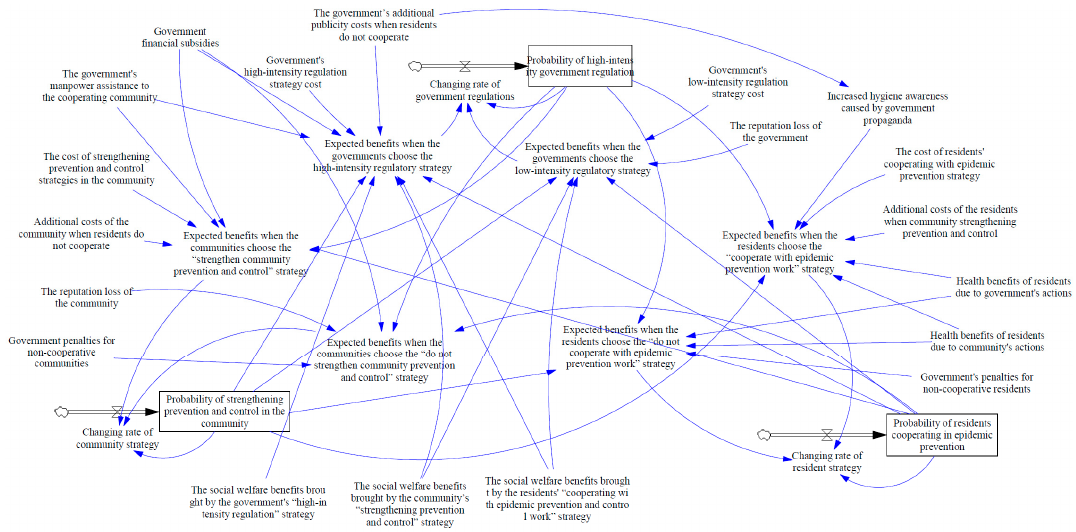
Figure 2. System dynamics stock-flow diagram of government departments, communities, and residents.